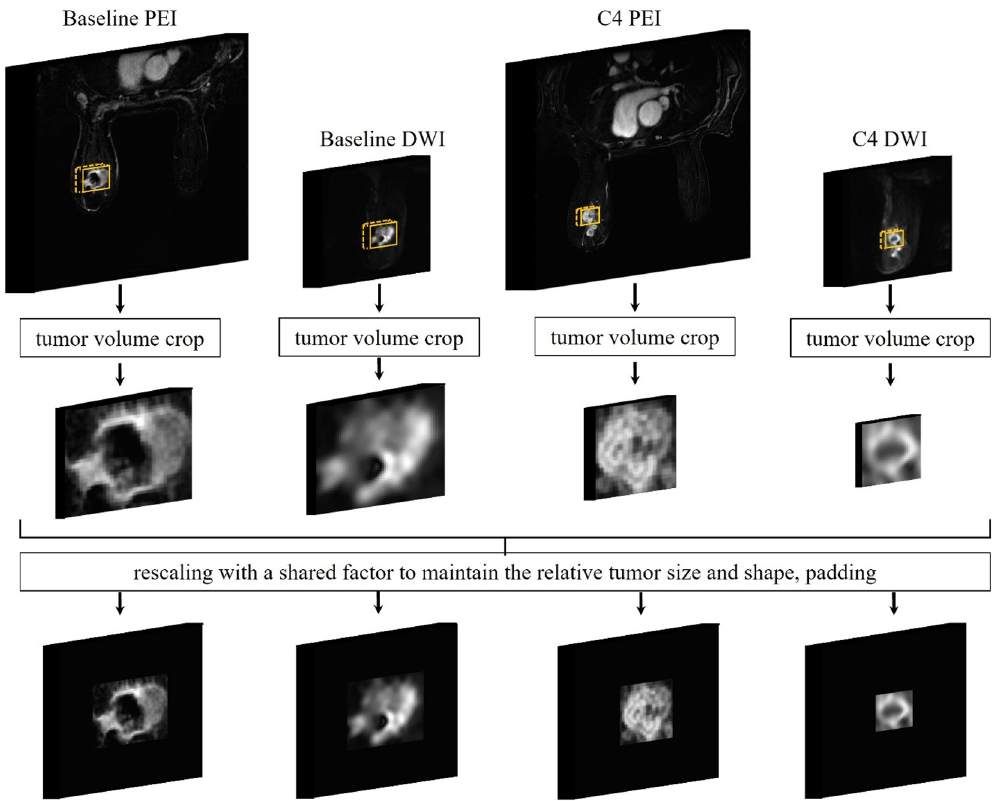
Figure 3. The image curation process. The tumors were cropped by placing tight bounding boxes based on the segmentations. The baseline tumor crops were first rescaled to the median size, then we used the same rescaling factor to resize the C4 tumor crops. Finally, all rescaled crops were zero-padded to the same sizes of 80 × 80 × 24 for the PEI, and 80 × 80 × 12 for the DWI. Such preprocessing approach permits maintaining the relative tumor shape across the patients, maintaining the relative tumor size across two scans, and avoiding large amounts of zero-padding, which can be more efficient for model training. The signal intensities were then normalized between 0 and